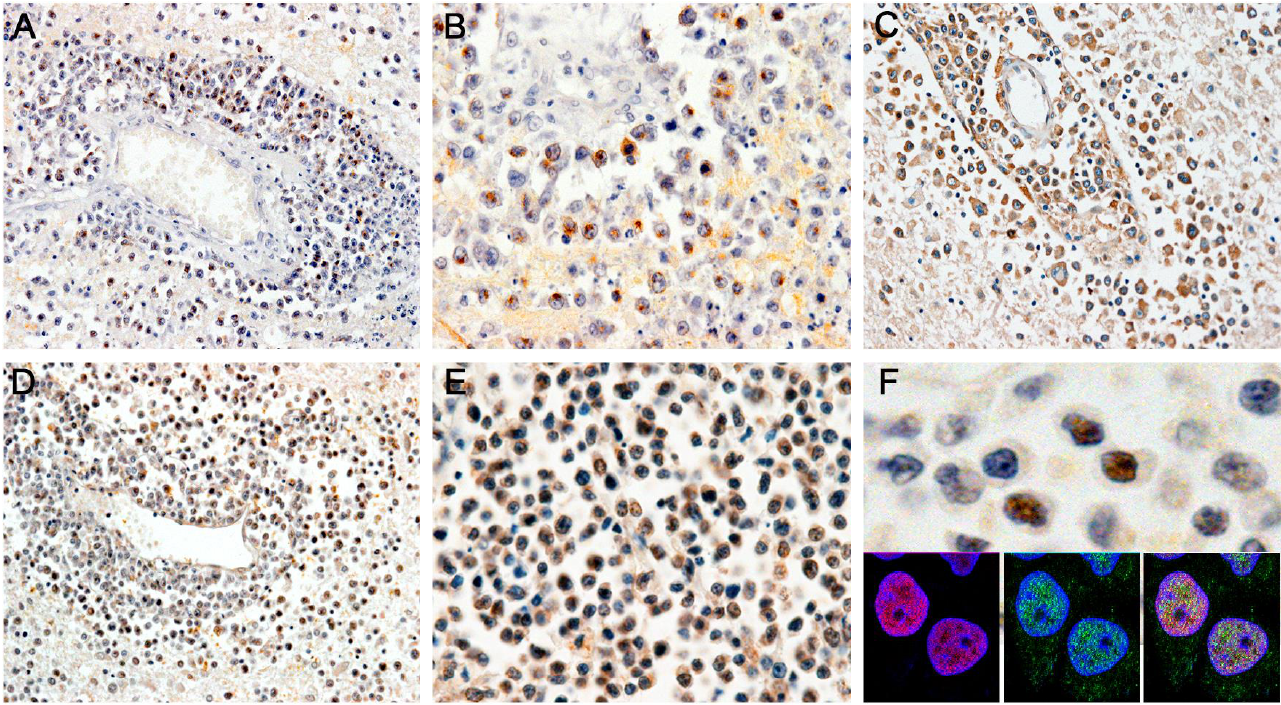
Figure 3. Immunohistochemical detection of EBV and JCPyV proteins: Immunohistochemistry for Epstein–Barr viral proteins showed the presence of the latent viral protein LMP1 in perivascular lymphocytic tumor cells (Panels ( A , B ), 100 and 400× magnification, respectively), and the EBER1 in the cytoplasm of the same cuffs of neoplastic lymphocytes (Panel ( C ), original magnification 100×). Large T-Antigen of the human neurotropic JCPyV was robustly expressed in the nuclei of several, but not all, perivascular neoplastic lymphocytes (Panels ( D – F ), original magnification 100×, 400×, and 1200×, respectively). Double-labeling demonstrated the co-localization of both T-Antigen and EBNA1 in the nuclei of neoplastic cells, Panel ( F ), inserts).